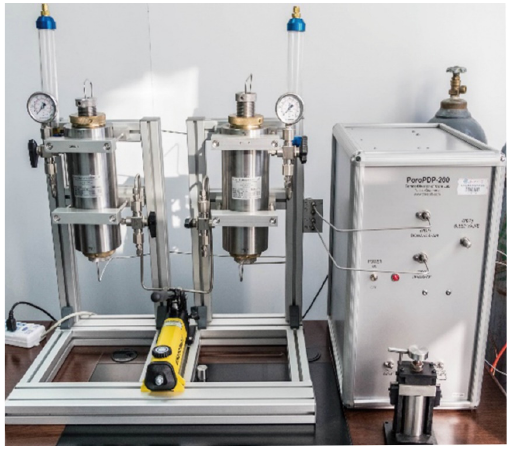
Figure 2. Pulse Decay Permeameter-PDP-200.